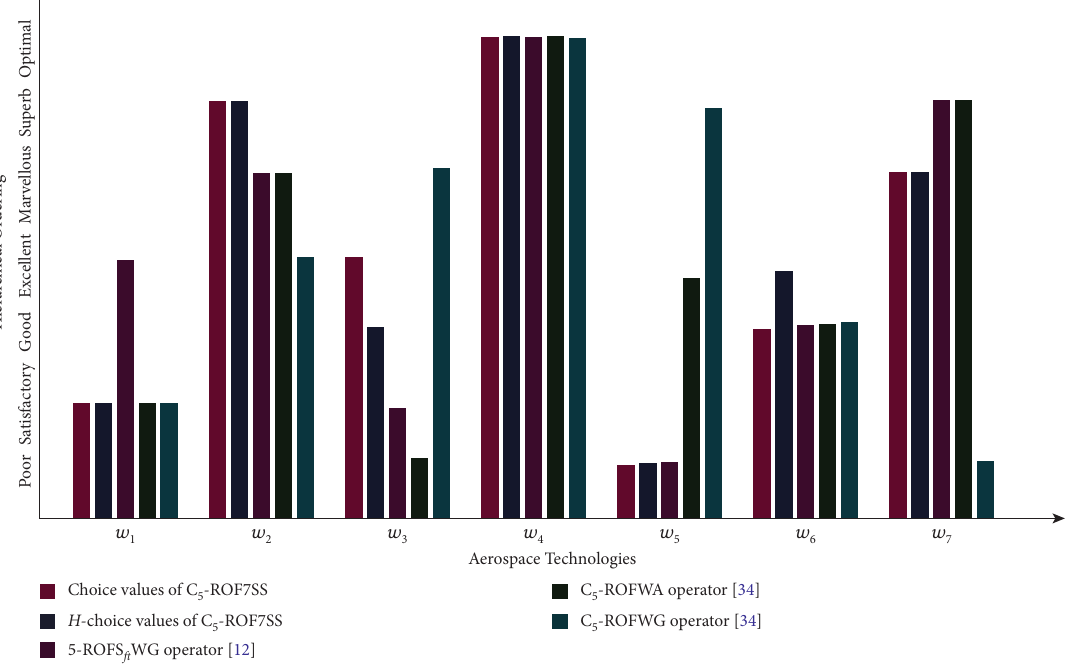
Figure 3: Comparative